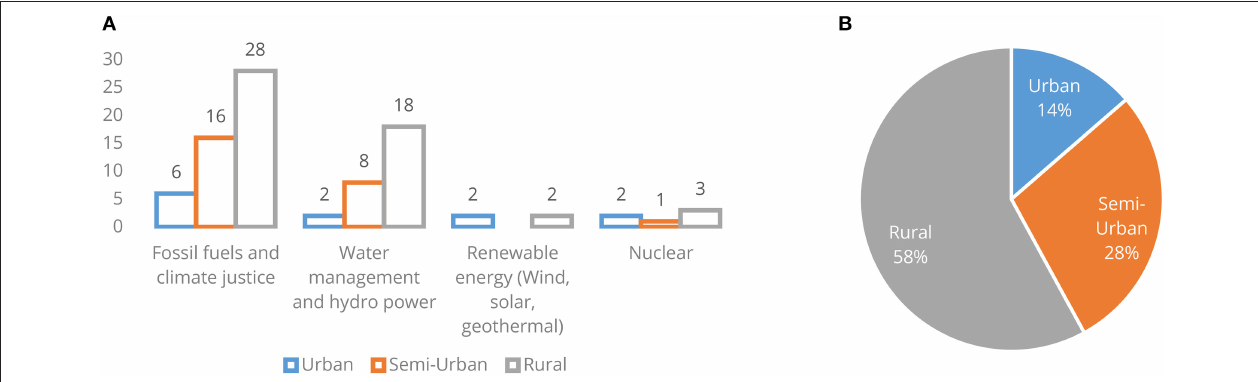
FIGURE 12 | Distribution of energy related conflicts in Turkey according to the population type (A) by the category of conflict, (B) total energy related conflicts. Source: Turkish Map of Environmental Justice, August 2016 .